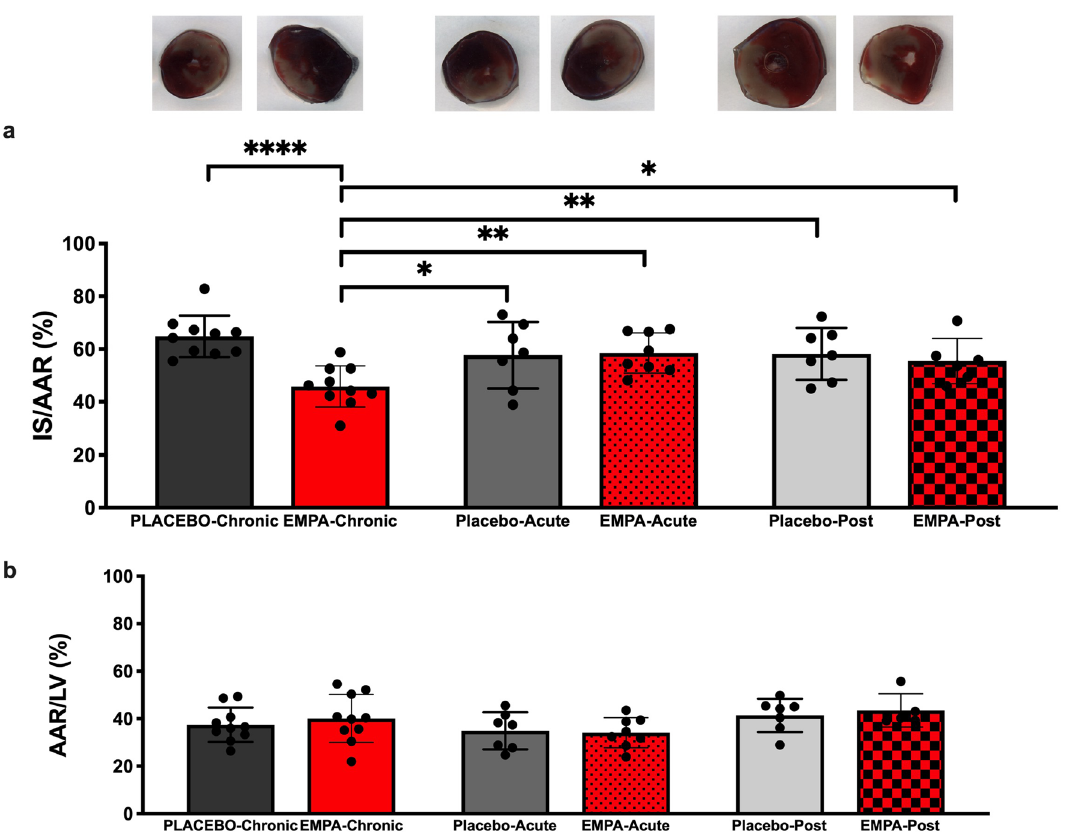
Figure 1. Myocardial infarct size following ischemia reperfusion in vivo. ( a ) Histological evaluation of infarct size with 2,3,5-triphenyltetrazolium chloride (TTC) staining, 2 h after reperfusion in PLACEBO-Chronic (n = 10); EMPA-Chronic (n = 10), PLACEBO-Acute (n = 7), EMPA-Acute (n = 8), PLACEBO-Post (n = 7) and EMPA-Post (n = 6) ( b ) The ratio of AAR/LV indicating the similarity of AAR between groups. AAR area at risk, IS infarct size, LV left ventricle. Mean ± SD. Statistical significance is shown as * p < 0.05, ** p < 0.01, **** p <